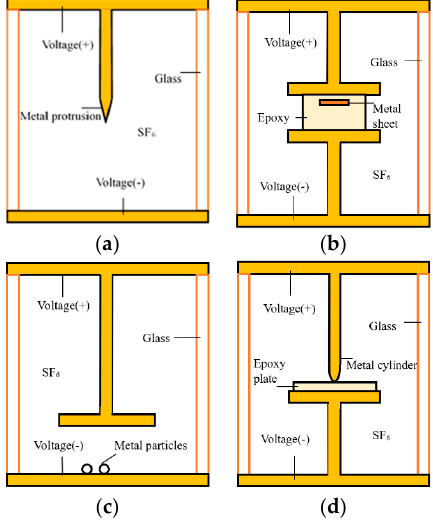
Figure 4. The designs of four typical kinds of insulation defects. ( a ) Metal protrusion; ( b ) Floating electrode; ( c ) Free metal particles; ( d ) Creeping